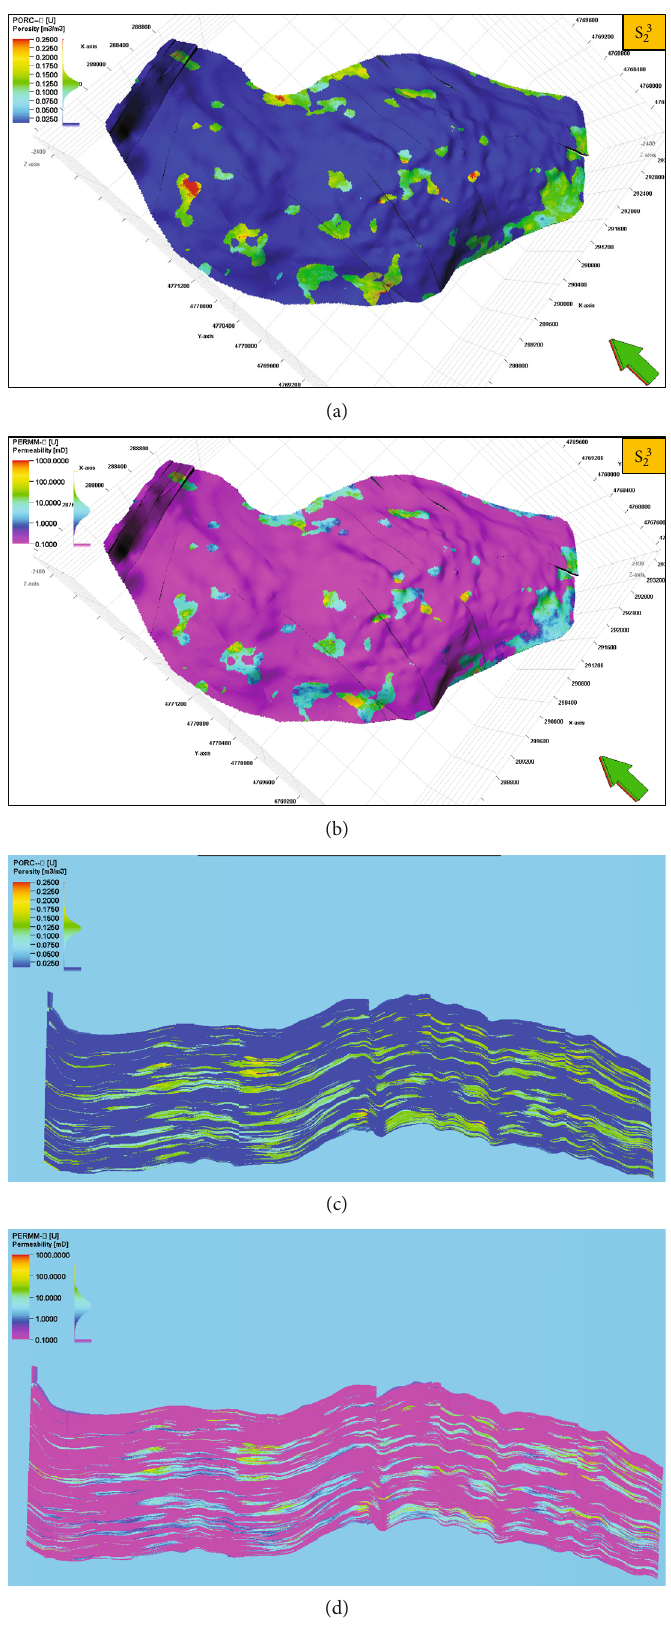
Figure 16: Porosity (a) and permeability (b) model of s 3 2 layer, longitudinal section of the porosity (c) and permeability (d)